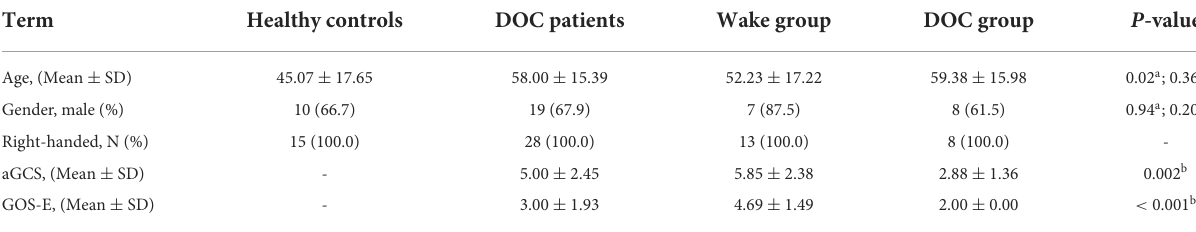
TABLE 1 Baseline characteristics of the study